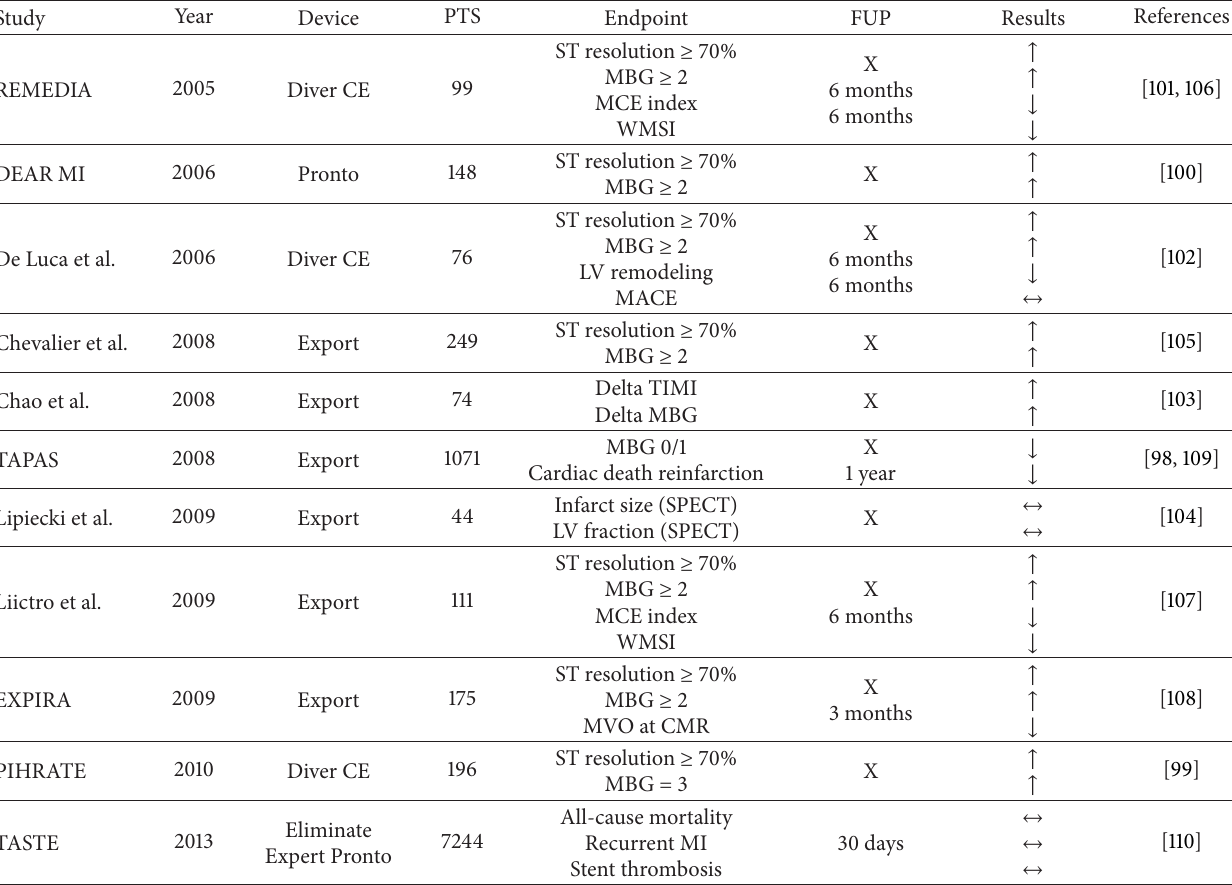
Table 2: Main results from clinical trials about manual thrombus aspiration compared to conventional PCI.